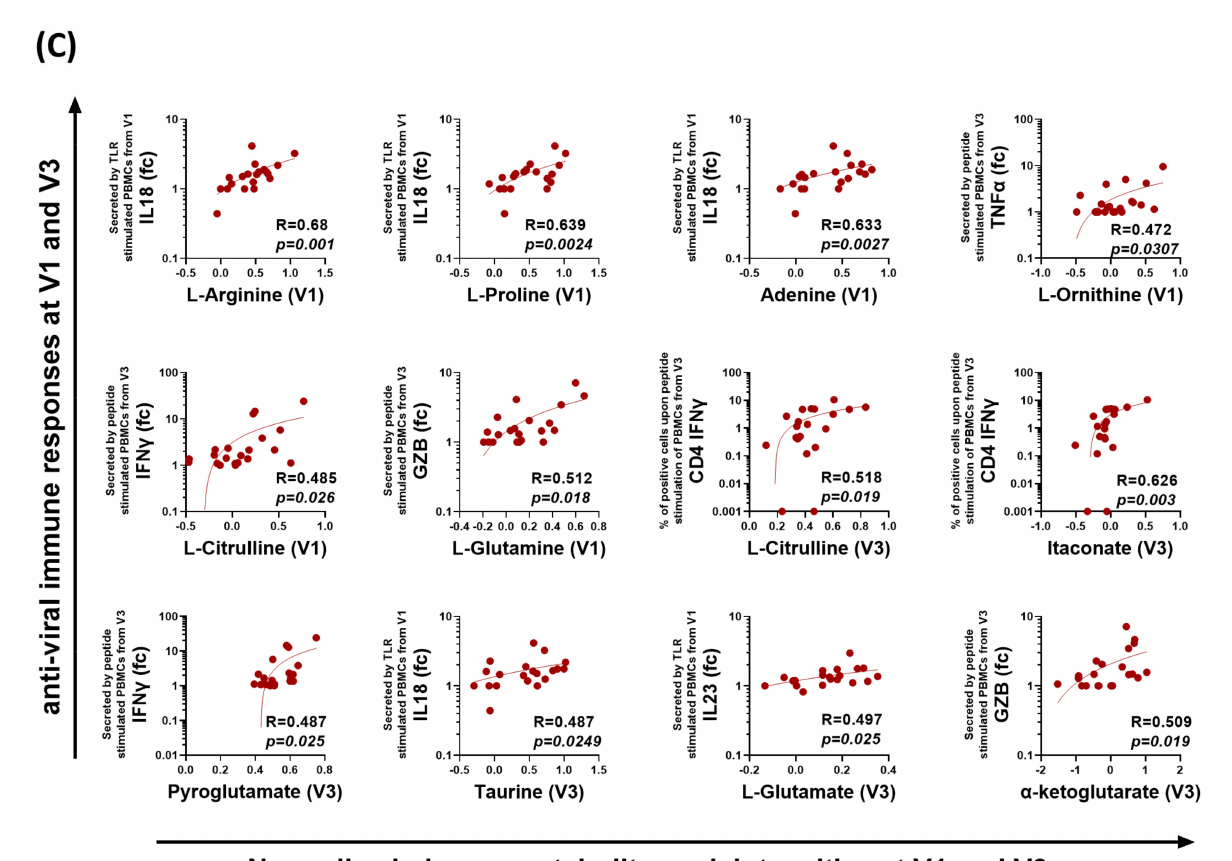
Figure 6. Correlation of metabolites with immune responses. Pathway analysis of plasma metabo- lites that significantly correlated (r > 0.45, p < 0.05) with ( A ) the TLR cocktail-induced innate immune response (V1) and ( B ) the T cell immune response (V3). ( C ) Representative correlation plots of metabolites from V1 and V3 that correlate with the cytokine release responses from TLR stimulated innate- and peptide pool-stimulated T cell immune responses. Each dot represents an individual sample. Spearman correlation coefficient (R) is indicated. GZB, granzyme B; fc, fold change–obtained by dividing the cytokine concentration in stimulated wells by unstimulated